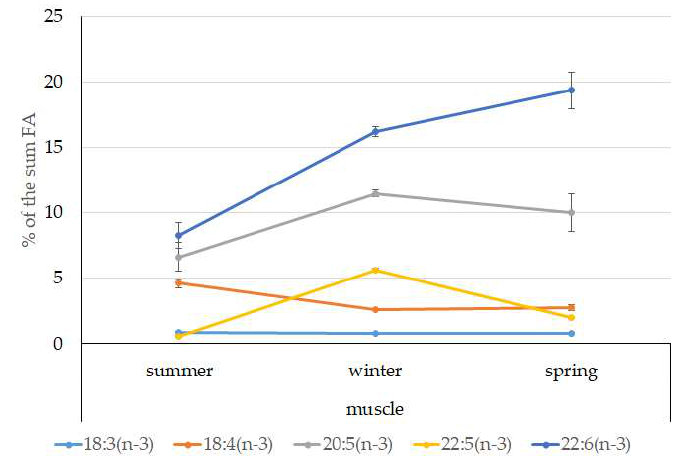
Figure 8. Seasonal dynamic of certain (n-3)PUFA levels (% of the sum of FAs) in muscle in postlarval (L3 developmental stage) daubed shanny from Kongsfjord. The data presented as M ± SE.